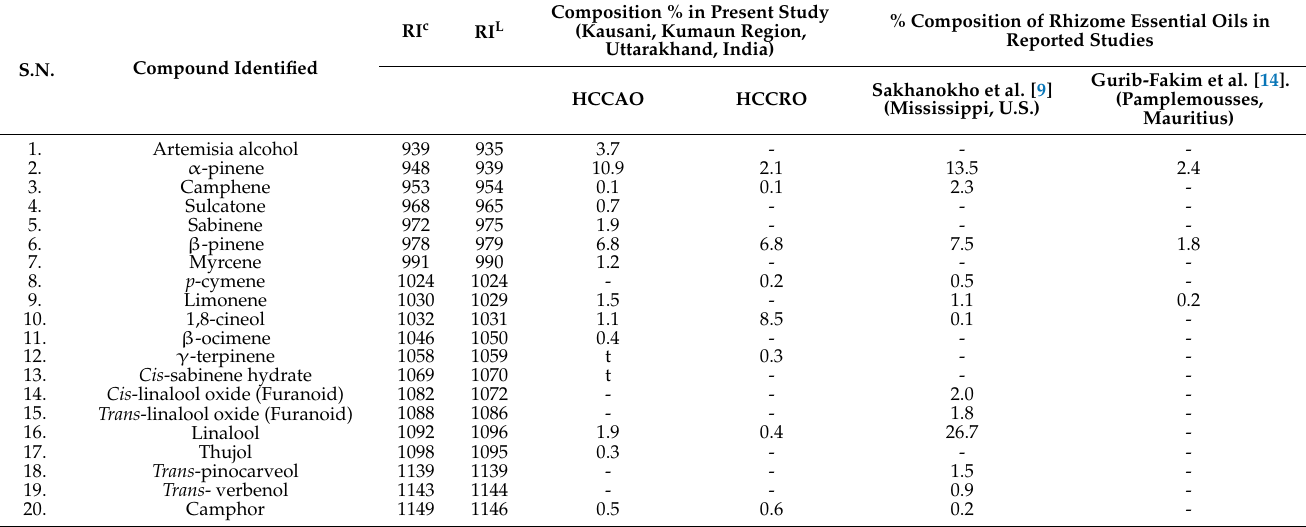
Table 1. Comparative chemical composition of HCCAO and HCCRO with previous